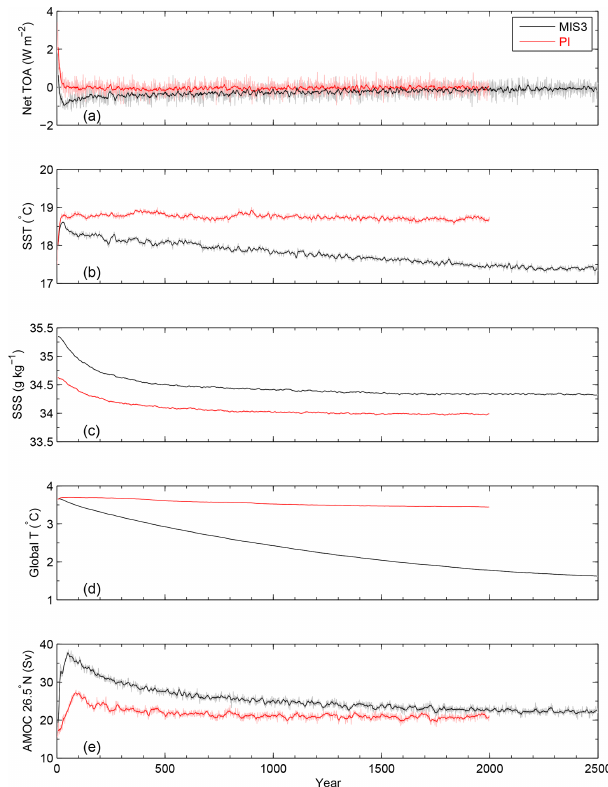
Figure 3. Time series of (a) TOA radiation balance, (b) SST, (c) SSS, (d) global mean ocean temperature, and (e) AMOC strength at 26.5 ◦ N for the MIS3 (black) and PI (red) experiments. Light colours denote annual mean values, and dark colours denote 10-year running mean